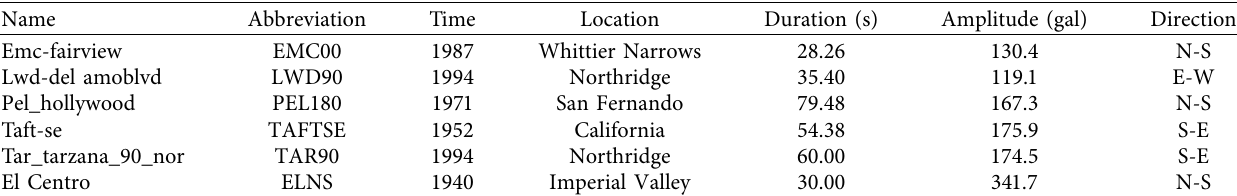
Table 2: Ground motion.